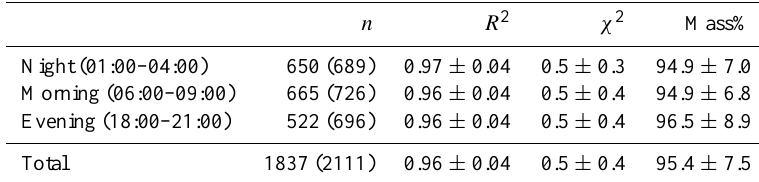
Table 3. Descriptive statistics on CMB model performance parameters for selected fits.